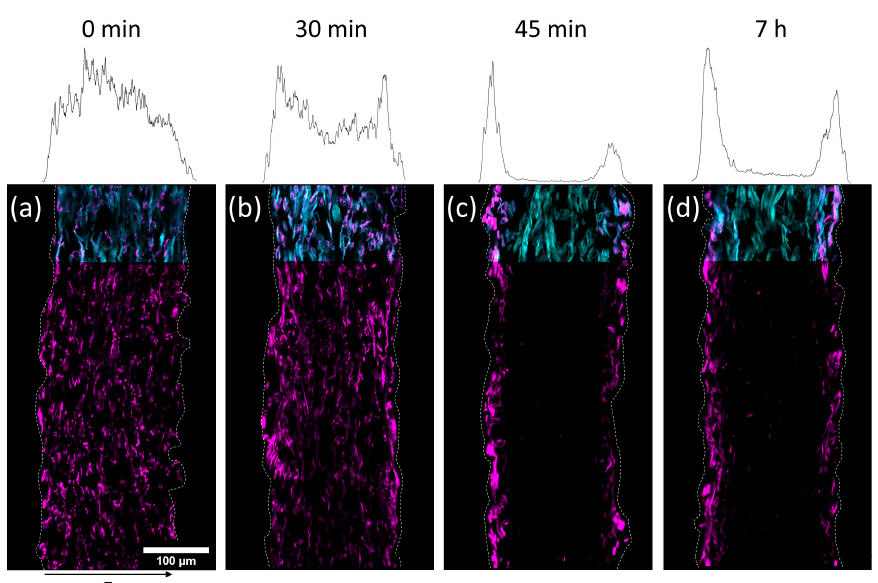
Figure 5. Cross-sections of paper samples modified with the photo-cross-linkable copolymer dis- solved in H 2 O (3.9 mg mL − 1 ), dried for different times (0 min ( a ); 30 min ( b ); 45 min ( c ); 7 h ( d )) before freeze-drying to stop the evaporation (i.e., transport of the copolymer), acquired by fluorescence CLSM. The fibers are stained with FB (cyan color, outline continued) and the copolymer fluoresces due to the rhodamine B label (magenta). The left side of the images corresponds to the side that was facing upwards during the drying and UV-excitation of samples. The z-distribution of the copolymer fluorescence is shown above each cross-section.